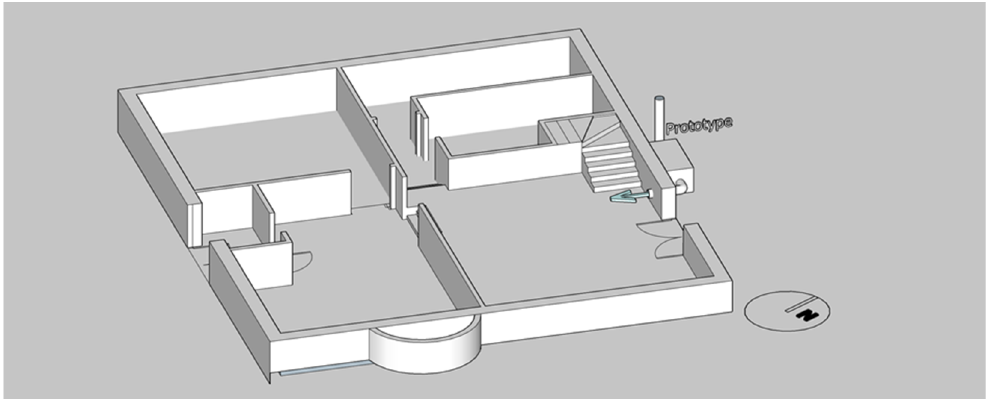
Figure 4. Plan of the installation. Source: created by author.